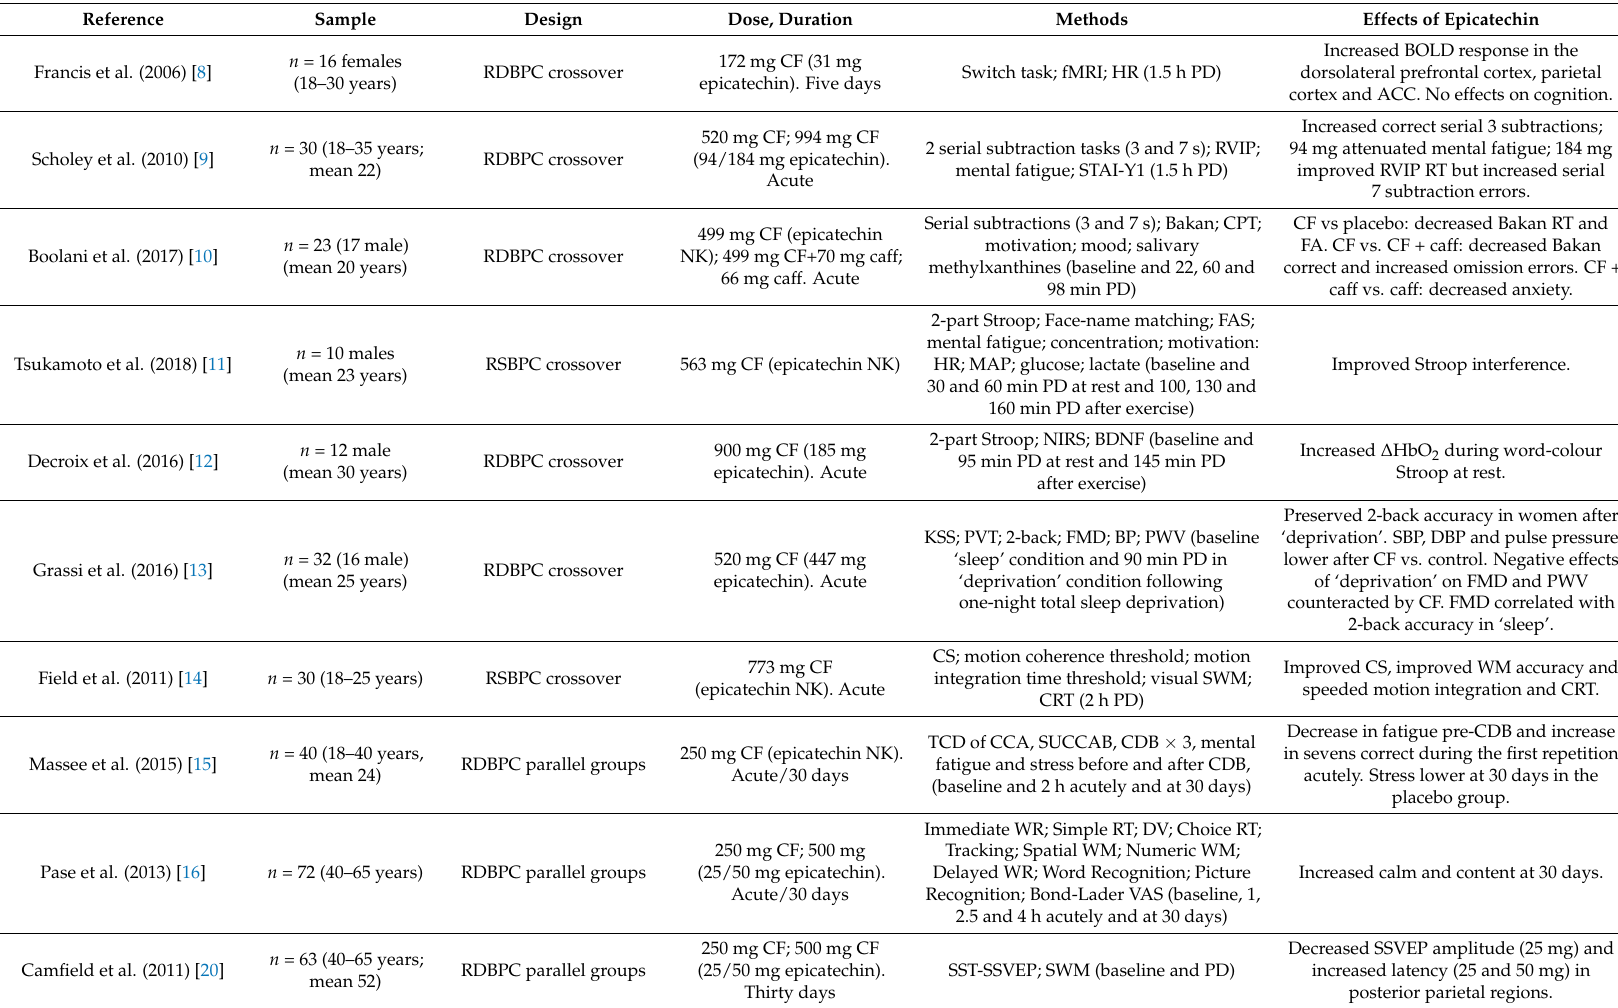
Table 1. Randomised controlled trials assessing the effects of cocoa on